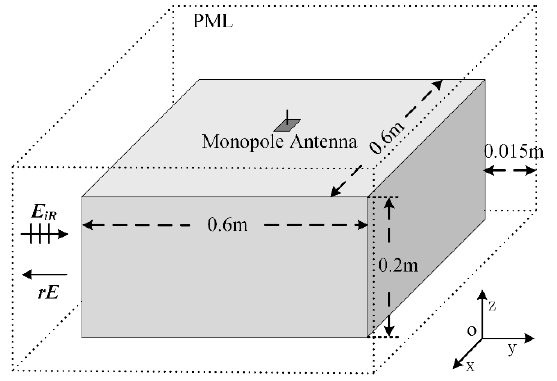
Figure 17. The sketch picture of active cancellation structure.